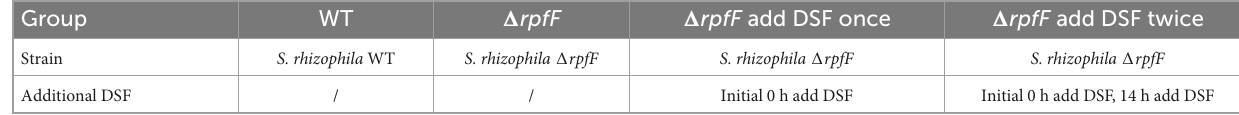
TABLE 1 DSF addback experiment. Group WT (cid:49) rpfF